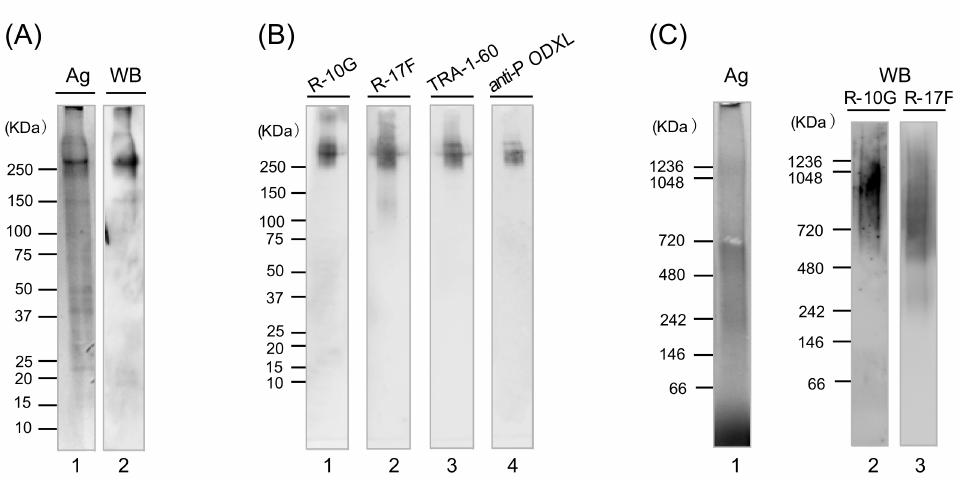
Figure 2. SDS-PAGE and blue native PAGE of R-10G-binding protein purified from 201B7 cells. ( A ) Purified R-10G-binding protein from 201B7 cells (1 ng protein) was resolved by SDS-PAGE on a 4–15% gradient gel under non-reducing conditions, followed by silver staining (lane 1) or Western blotting using R-10G (3 µ g protein/mL) (lane 2). ( B ) The purified R-10G-binding protein from 201B7 cells (0.25 ng protein) was resolved by SDS-PAGE on a 4–15% gradient gel under non-reducing conditions, followed by Western blotting with the following antibodies (3 µ g protein/mL): R-10G (lane 1), R-17F (lane 2), TRA-1-60 (lane 3), and anti-podocalyxin (lane 4). ( C ) R-10G-binding protein purified from 201B7 cells (1 ng protein in lane 1, 0.3 ng in lanes 2 and 3) was resolved by blue native PAGE on a 3–12% gradient gel under non-reducing conditions, followed by silver staining (lane 1) or Western blotting using antibodies (3 µ g protein/mL) against R-10G (lane 2) and R-17F (lane 3). SDS-PAGE of the purified R-10G-binding protein, followed by Western blotting using the R-10G, R-17F, and TRA-1-60 antibodies, yielded a single major band at ~250 kDa, similar to that yielded using the anti-podocalyxin antibody (Figure 2B), suggesting that the R-10G, R-17F, and TRA-1-60 glycan epitopes are present on a common core protein,